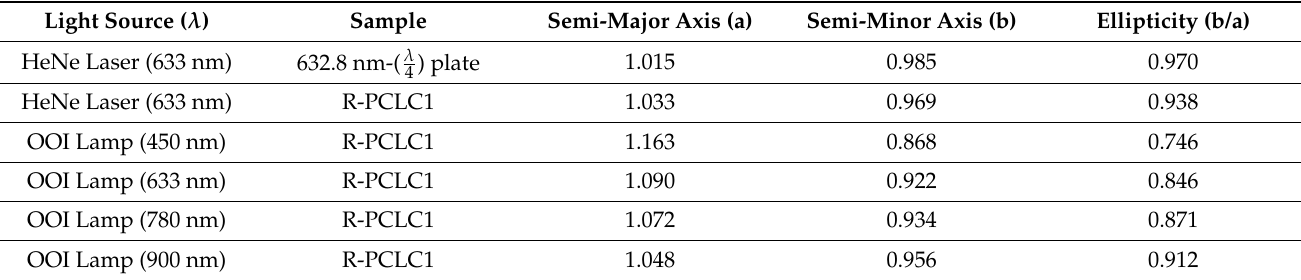
Table 1. The length of semi-major axis a, the length of semi-minor axis b, and the ellipticity (b/a) were obtained by fitting the circularly polarized light data in Figure 5 to the elliptic equation.